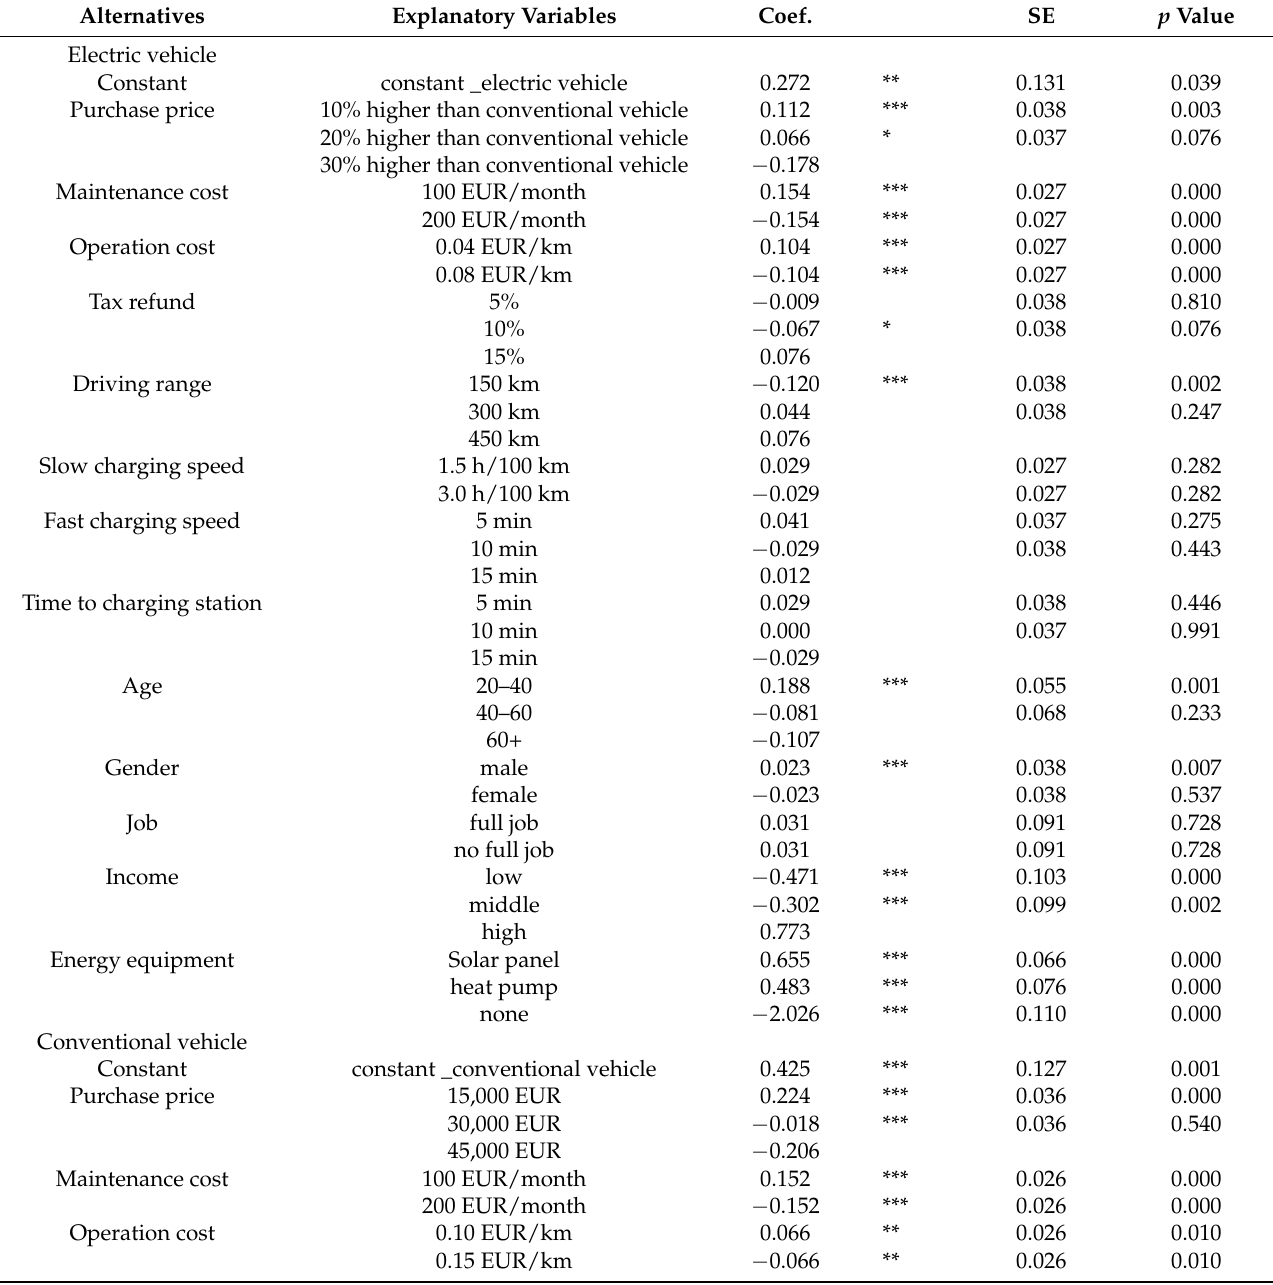
Table 4. Estimation results of Model